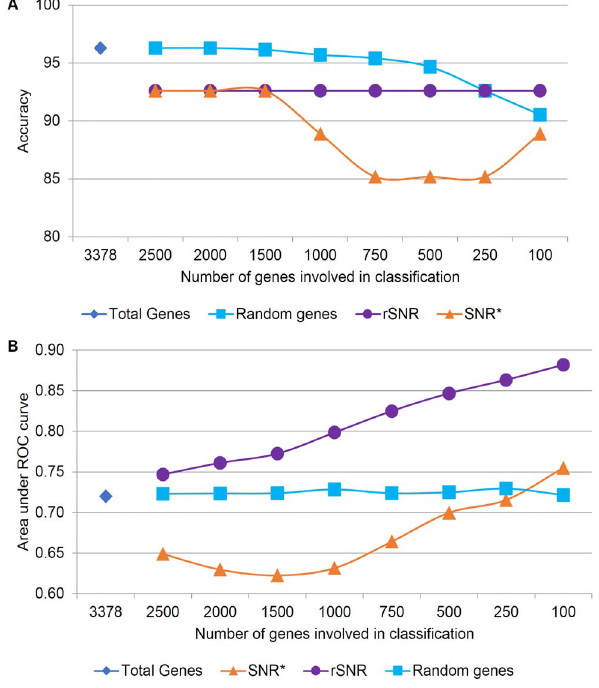
Figure 7. Effect of feature selection methods on the classifica- tion of the Engreitz dataset. A) Accuracy. B) Area under the ROC curve (AUC).